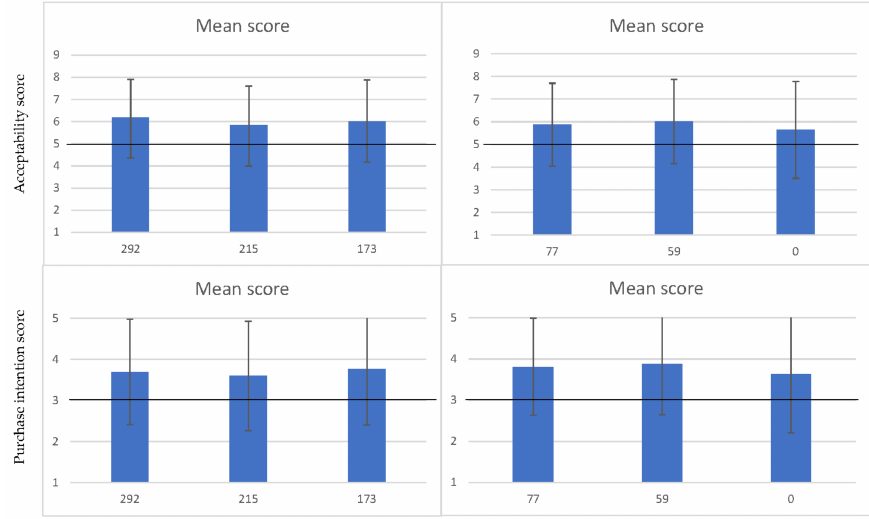
Figure 2. Mean scores for acceptability and purchase intention